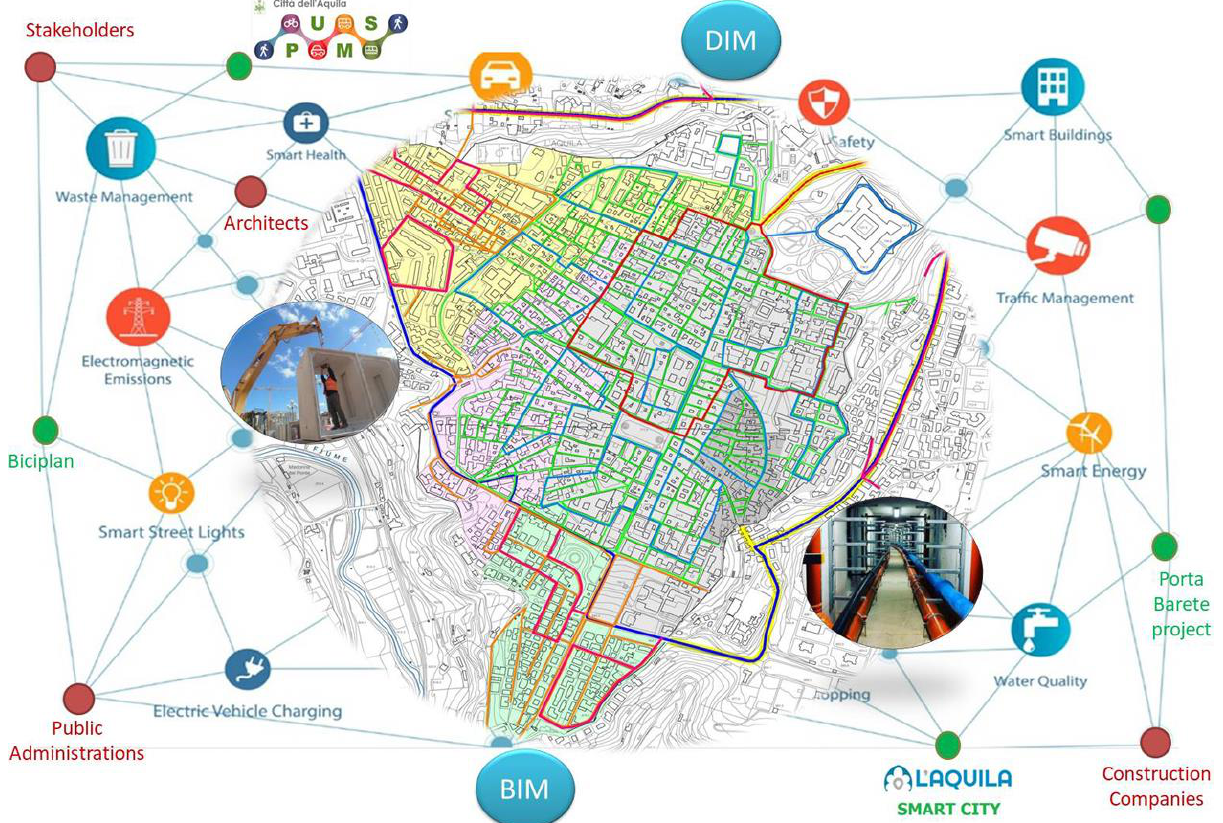
Figure 9. Scheme of the developed programmatic tool. It is based on District Information Modeling, DIM, that is a BIM implementation on an urban